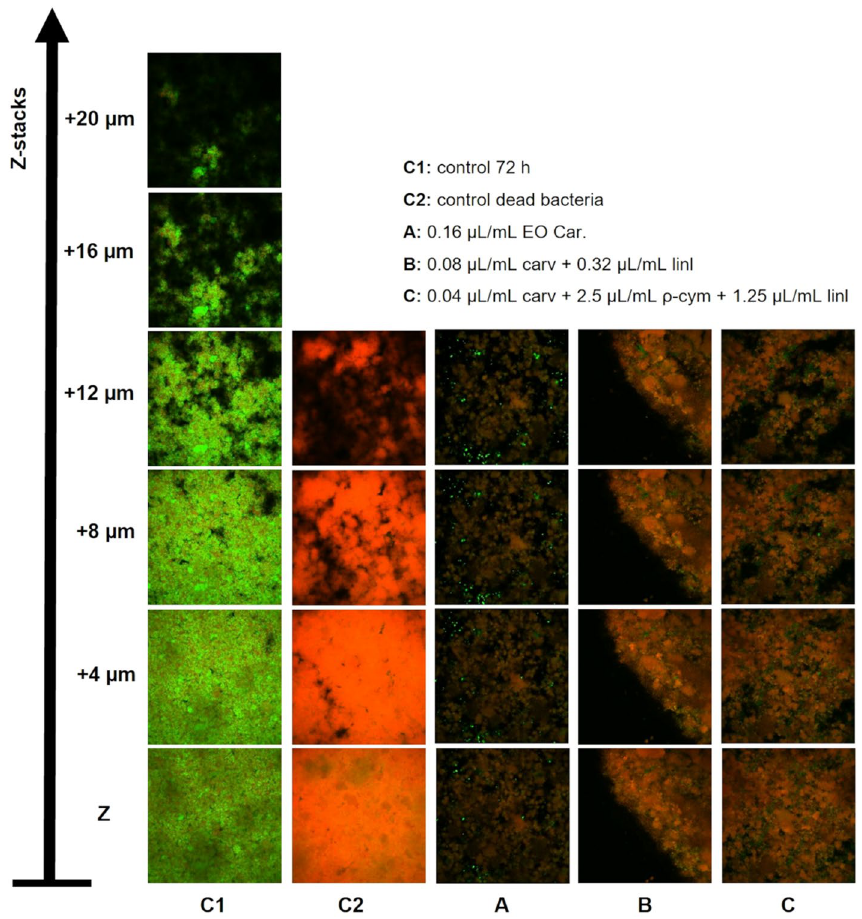
Figure 4. Representative images of CLSM analysis of G. vaginalis UM137 72 h biofilm after the activity of EO Car. and some specific combinations using LIVE/DEAD staining. The images were acquired using an objective of 10 × and z-stacks of 4